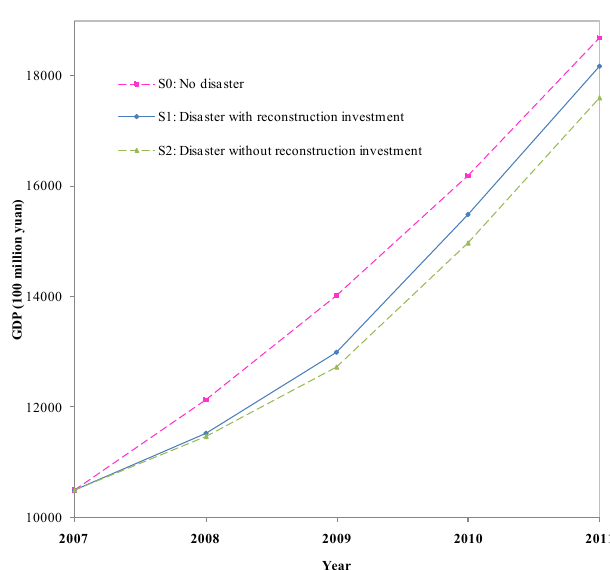
Fig. 3. GRP of Sichuan Province from 2007 to 2011 in three scenarios according to the CGE model.